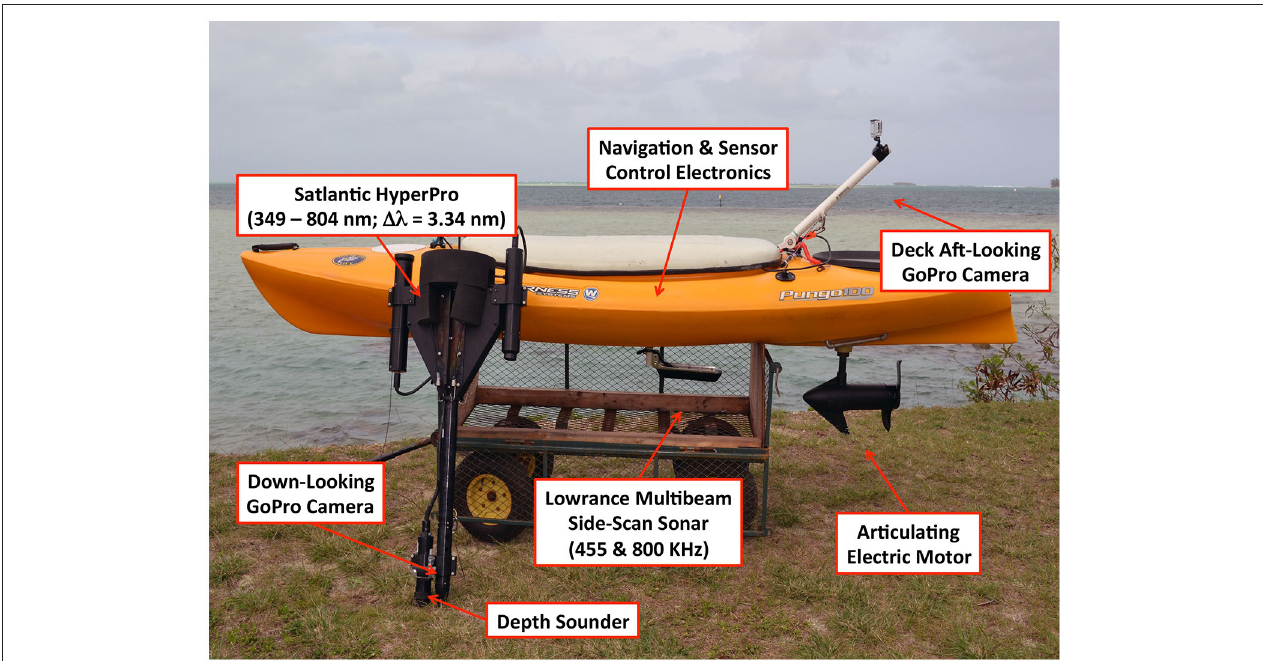
FIGURE 2 | A survey of the coconut patch reef was conducted on 12 February 2017 using an instrumented, autonomous kayak capable of navigating pre-planned routes and collecting simultaneous optical and acoustical observations of benthic features in high spatial resolution.